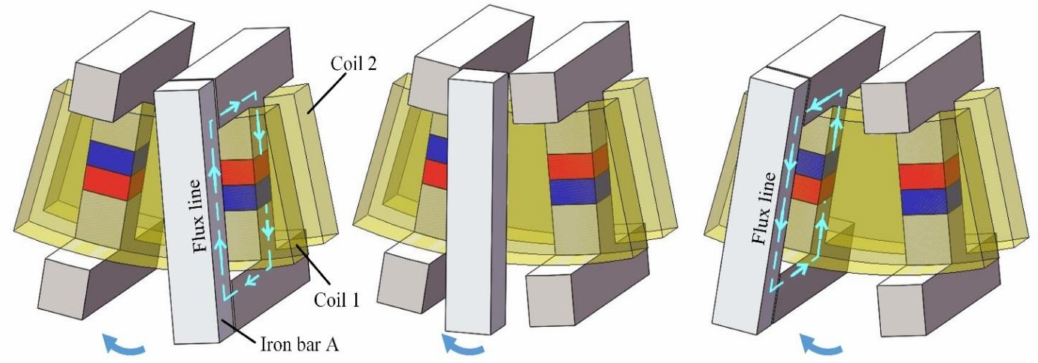
Figure 2. Operating principle of the proposed TFPMDG with H-shaped stator